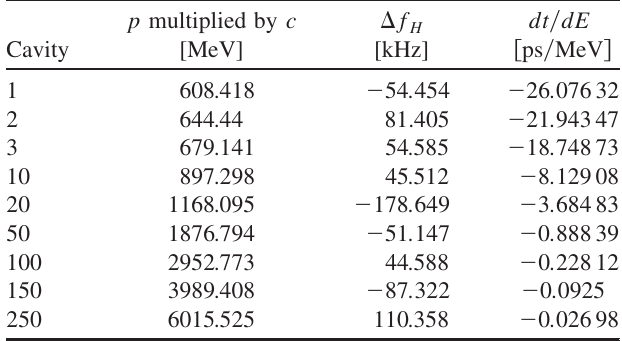
TABLE I. Example of some of the 250 cavities of the linac and their data: nominal momentum ( p multiplied by c ) at the down- stream cavity end, its (random) deviation of the HOM frequency (Gaussian scatter (cid:1) ¼ 100 kHz ) from the (random) nominal value, and the time slip per energy deviation constants dt=dE ð E Þ .